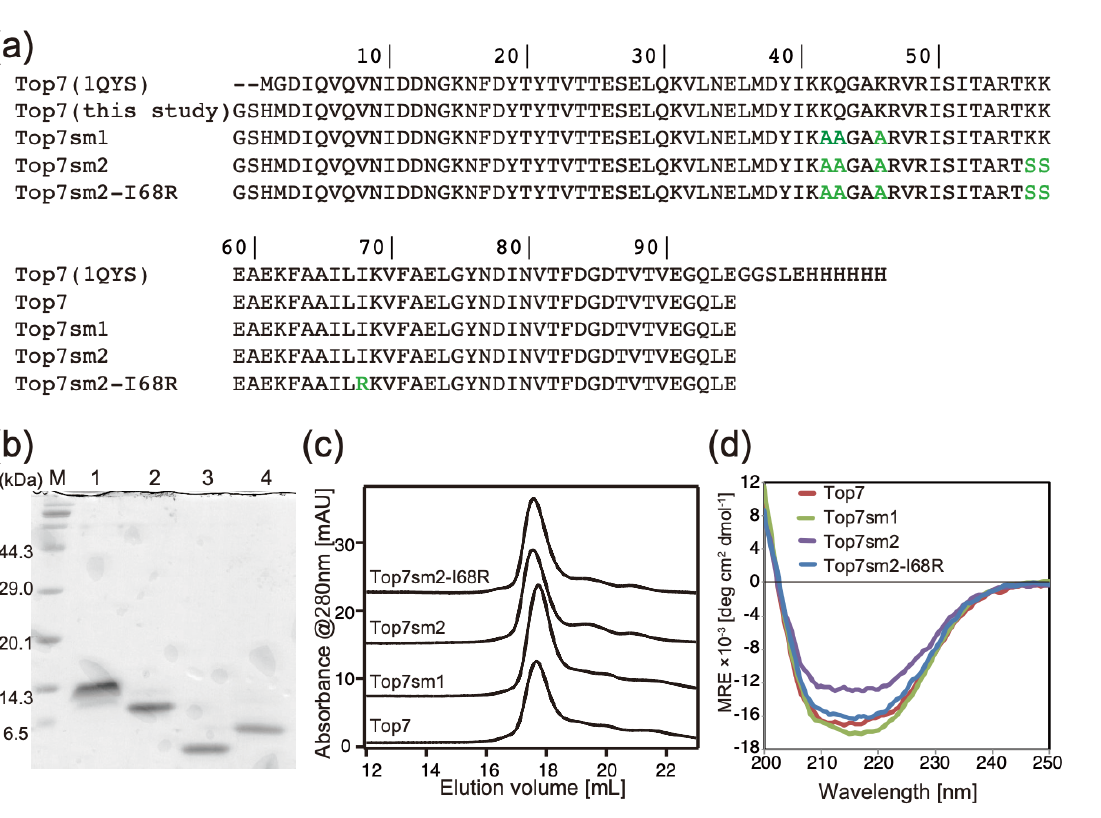
Figure 1. ( a ) Amino acid sequences of Top7 and its variants used in this study. Mutated residues are shown in green characters. ( b ) Purified protein samples analyzed by SDS-PAGE. M: molecular- weight marker, 1: Top7, 2: Top7sm1, 3: Top7sm2, 4: Top7sm2-I68R. ( c ) Analytical size-exclusion chromatography. Chromatograms at 280 nm absorbance were shown. Each chromatogram is shifted vertically for clarity. ( d ) Far-UV CD spectra of TOP7 surface mutants.